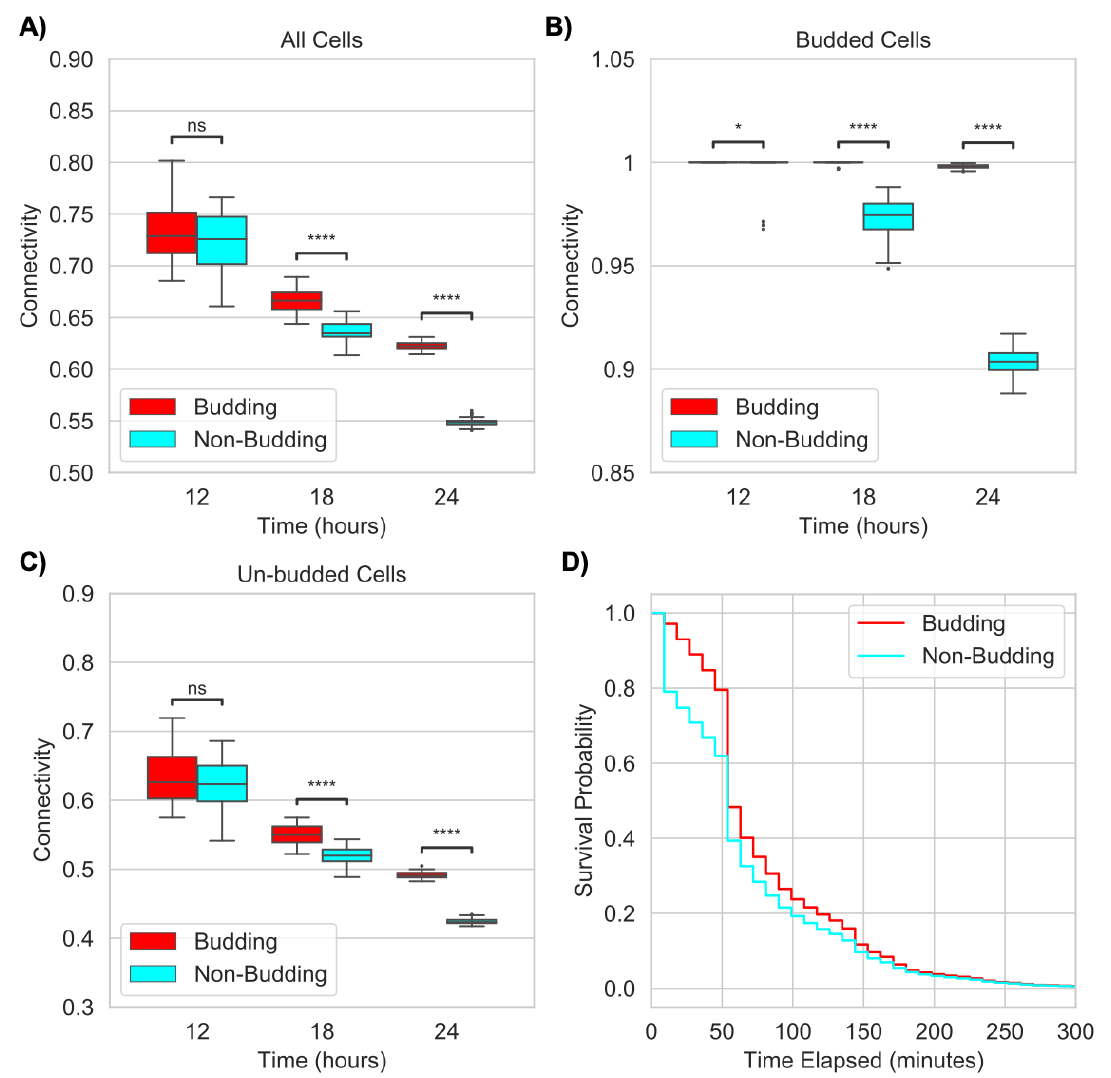
Figure 5. Colony Connectivity in Nutrient-Rich Colonies. Comparison of colony connectivity between budding (red) and non-budding (blue) colonies at 12, 18 and 24 h. We compared connectivity for all cells in ( A ), as well as cells in two distinct phases: during the time when cells are attached for budding colonies in ( B ) and after separation in ( C ). (See Section 4.2.2 for how we define connectivity.) ( A ) We observe a statistically significant difference in colony connectivity at 18 h ( p = 1.423 × 10 − 27 ) and 24 h ( p = 2.008 × 10 − 99 ). ( B ) We observe a rapid decrease in connectivity between both 12–18 and 18–24 h in non-budding colonies. This decrease leads to a statistically significant difference between budding and non-budding colonies at 12 h ( p = 3.387 × 10 − 02 ), 18 h ( p = 6.521 × 10 − 34 ) and 24 h ( p = 2.867 × 10 − 103 ). ( C ) We observe a statistically significant difference in connectivity at 18 h ( p = 3.684 × 10 − 19 ) and 24 h ( p = 7.615 × 10 − 89 ). ( p -values for connectivity were computed using independent t -tests. p -value annotation is as follows. *: 1.0 × 10 − 2 p ≤ 5.0 × 10 − 2 , **: 1.0 × 10 − 3 p ≤ 1.0 × 10 − 2 , ***: 1.0 × 10 − 4 p ≤ 1.0 × 10 − 3 , ****: p ≤ 1.0 × 10 − 4 .) ( D ) Kaplan-Meier survival curves for the edge connecting mother-daughter cell pairs in G S for budding (red) and non-budding (blue) colonies. The y -axis is the probability that a given mother-daughter edge will remain in G S for longer than t hours after separation, where time is on the x -axis. We observe that the survival curves are different between the two groups ( p = 7.217 × 10 − 25 ), indicating that the probability that a mother-daughter edge remains in G S for longer than t hours is greater for budding colonies. (The p -value comparing survival curves was calculated using a log-rank test as described in Section 4.3.) (See Section 2.1.3 for